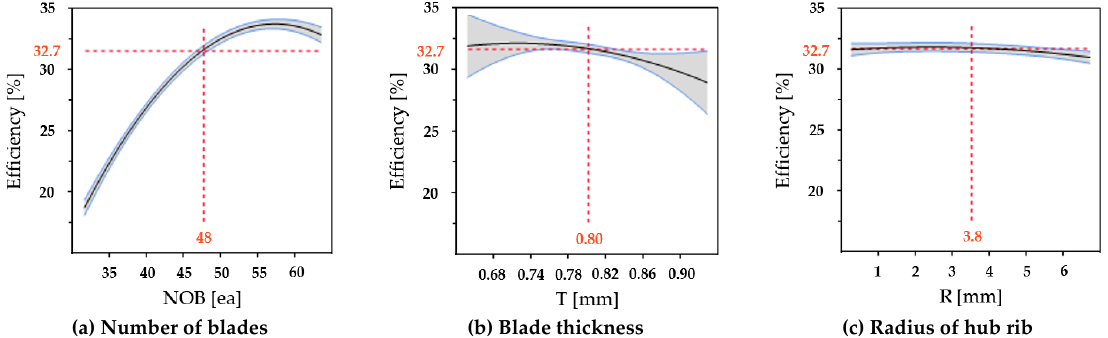
Figure 10. E ff ects of the design variables on pump e ffi Figure 10. Effects of the design variables on pump efficiency.